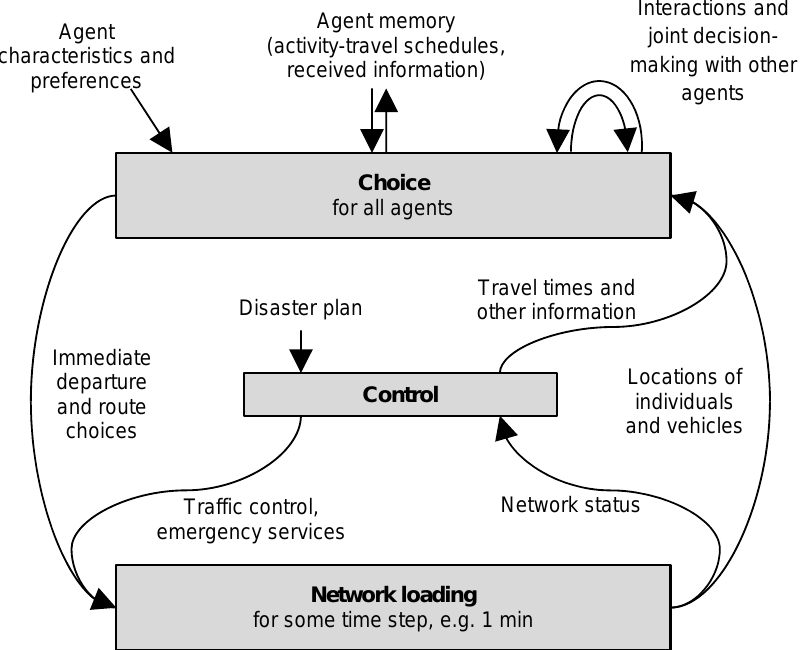
Figure 2. Detailed flow chart of the parallel procedure for the emergency